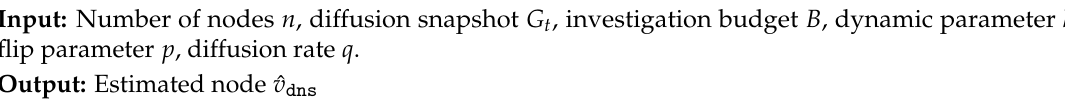
Algorithm 1 Dynamic Network Source Estimation (DNSE( k